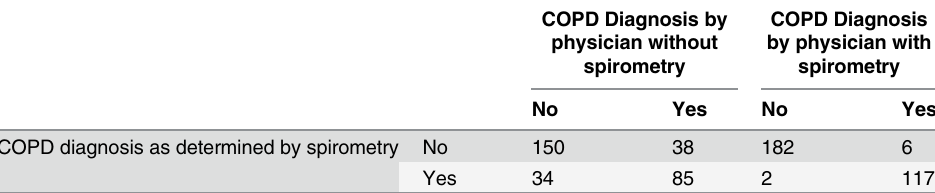
Table 2. Physician diagnosis of COPD without and with spirometry.